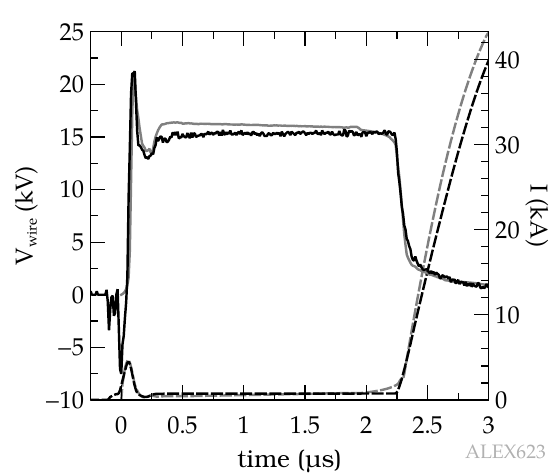
Figure 4. Wire voltage ( experimental, calculated), and current ( experimental, calculated) signals for a charging voltage of 18 kV during the dark pause. In both calculations, R 2 ≈ 0.8 and p -value < 10 − 3 .